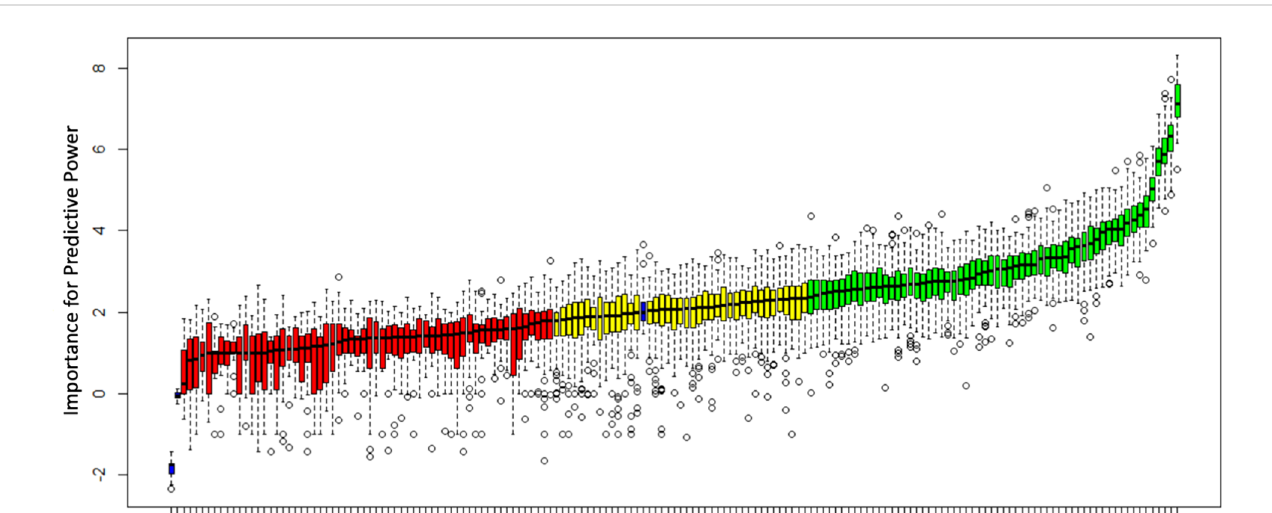
FIGURE 1 Analysis of predictive power for the diagnosis of GHD using Boruta. All 160 genes utilized in this study are shown and predictive power compared to shadow variables (blue bars) generated from permuted data. Genes are classi fi ed as con fi rmed, tentative or rejected based on a comparison with the shadow variables. 60 genes were con fi rmed (green), 40 tentative (yellow) and 60 rejected (red). A median importance score ≥ 2.359 resulted in a con fi rmed status, a score ≥ 1.785 and < 2.359 resulted in tentative status and a score <1.785 rejected status.